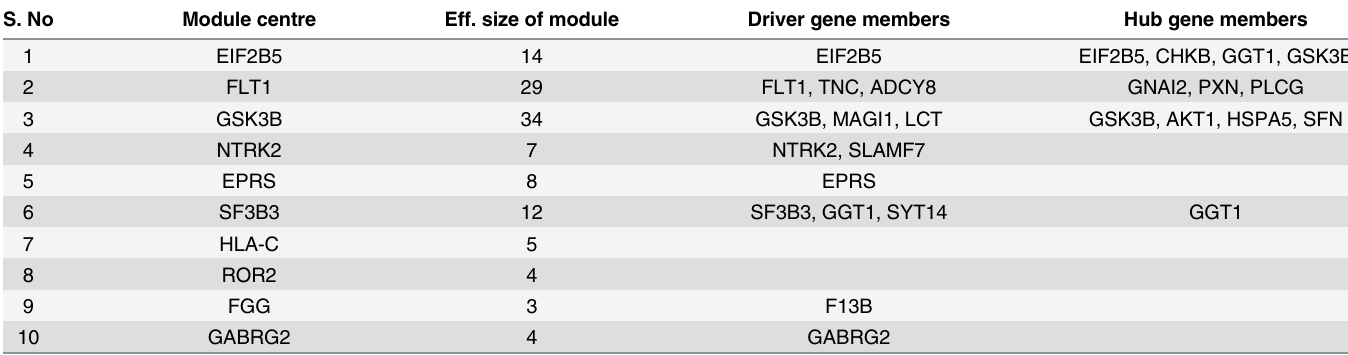
Table 9. Moduland decomposition of stage-IV